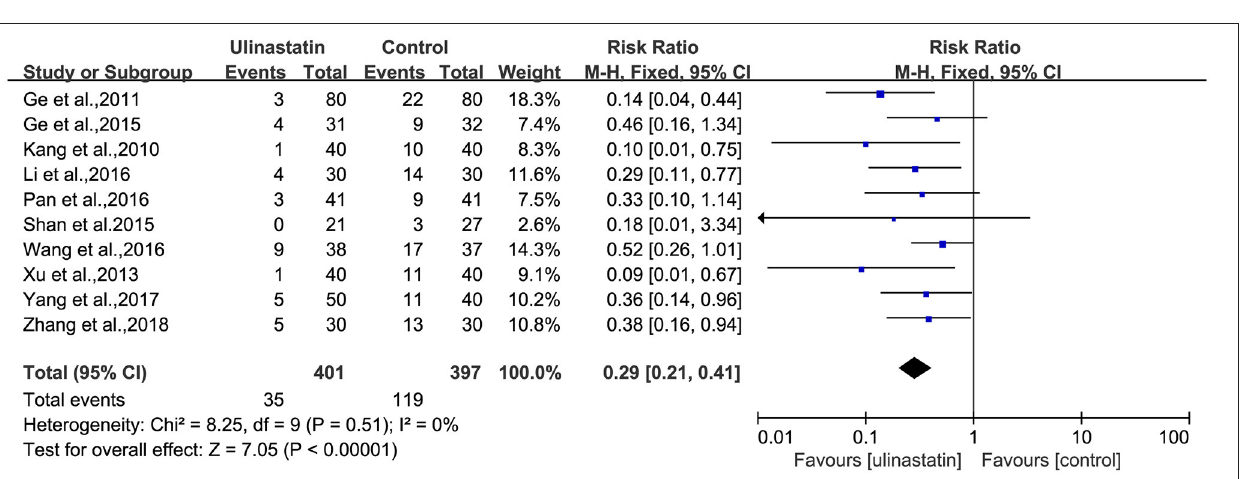
FIGURE 3 | Forest plot: Meta-analysis and pooled risk ratio (RR) of the effect of ulinastatin on postoperative cognitive dysfunction